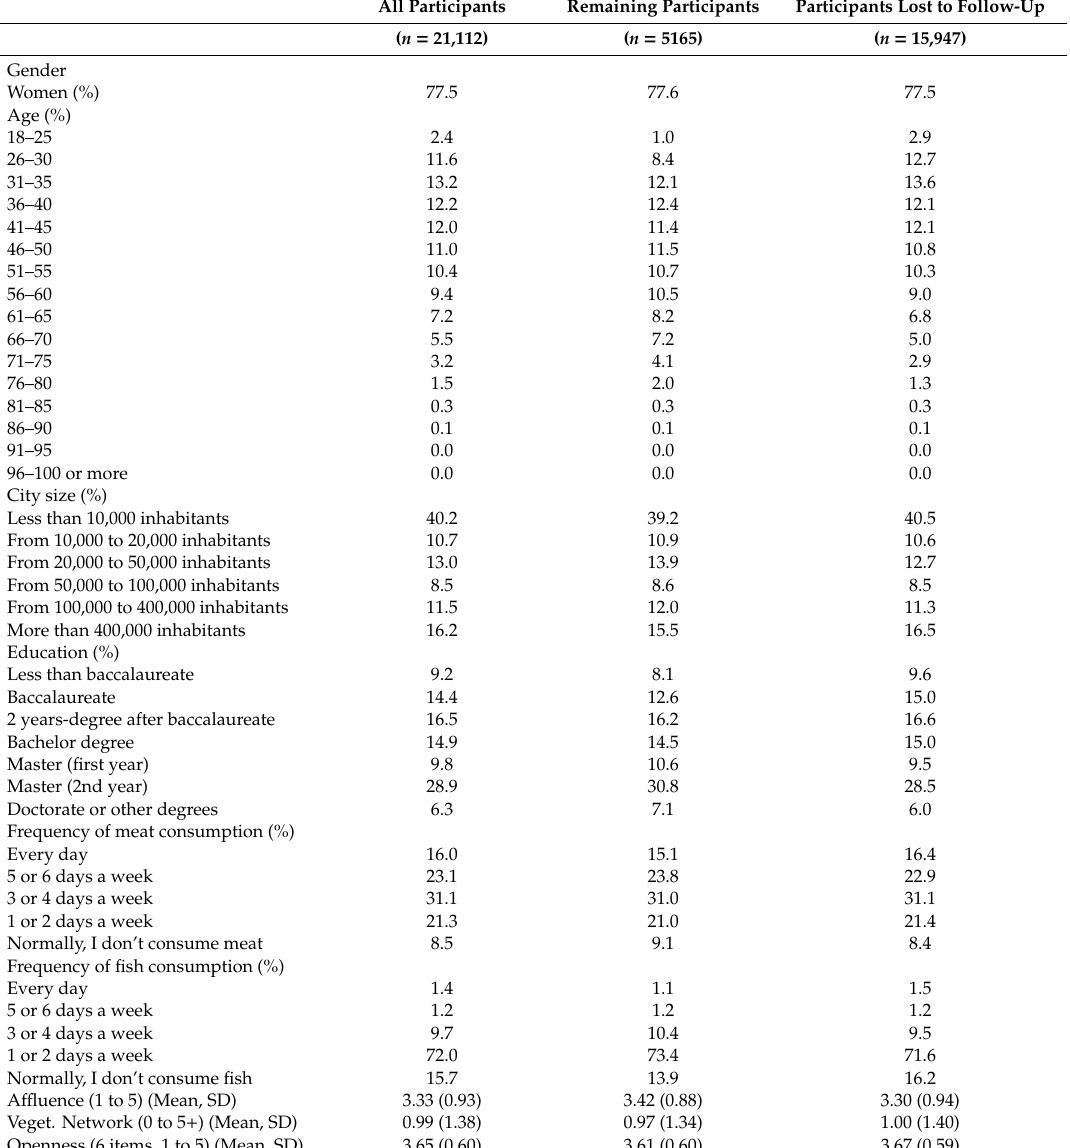
Table 3. Characteristics of all participants, of those that answered all 15 weeks and those lost at any follow up